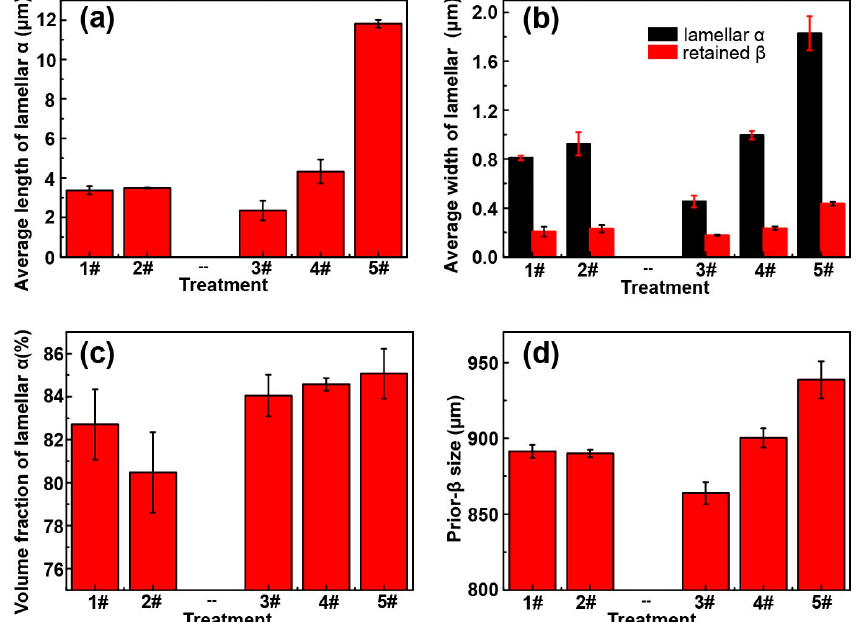
Figure 10. Statistical microstructural features of TC4F after heat treatments. ( a ) Average length of lamellar α , ( b ) average width of lamellar α and retained β , ( c ) volume fraction of lamellar α , and ( d ) average prior- β size. Table 3. Statistical microstructural features of TC4F after heat treatments.